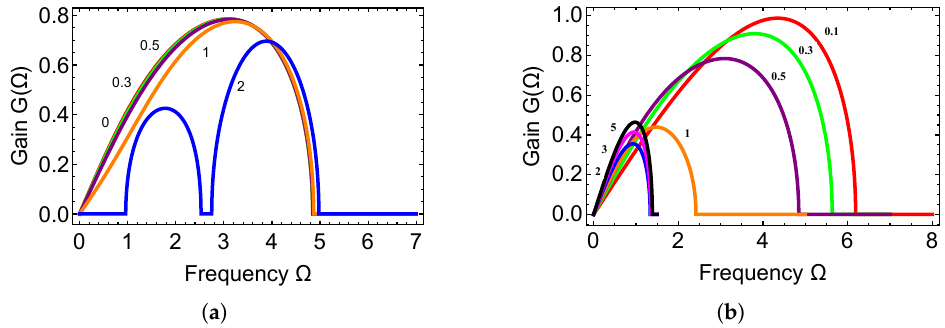
Figure 4. The MI gain spectra in the anomalous-GVD regime ( σ 1 = 1). ( a ) Results for different values of the group-velocity mismatch ( ρ in Equation (5)), which are indicated near the curves. Other parameters are P = κ = Γ = 1, η = 0.5 and α = 0.1 ( b ) Results for different values of asymmetry ratio η of the CW state (see Equation (8)), which are indicated near the curves. Other parameters are P = 0.5, κ = 1, α = 0.1, Γ = 2 and ρ =